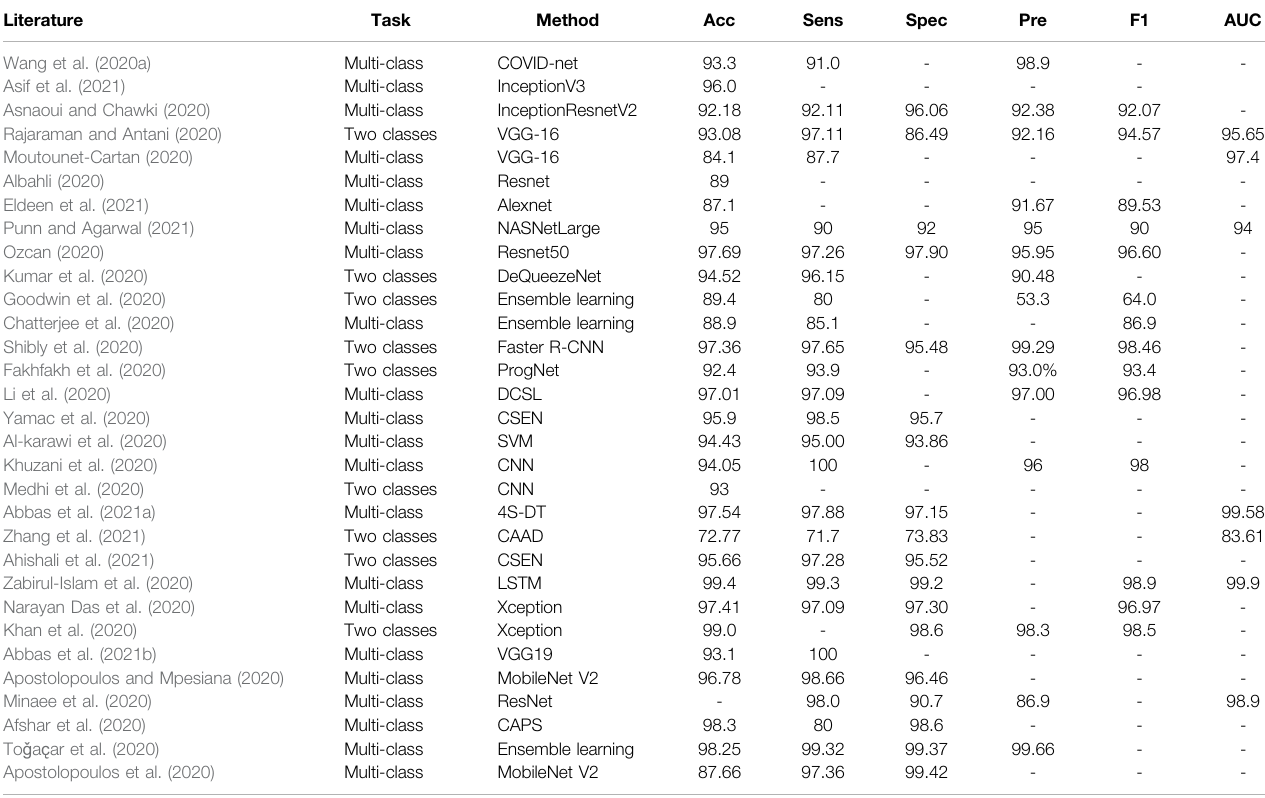
TABLE 1 | Summary of COVID-19 detection from CXR images in the literature (%). If multiple models are used in a study, we report the best-performance model here. Literature